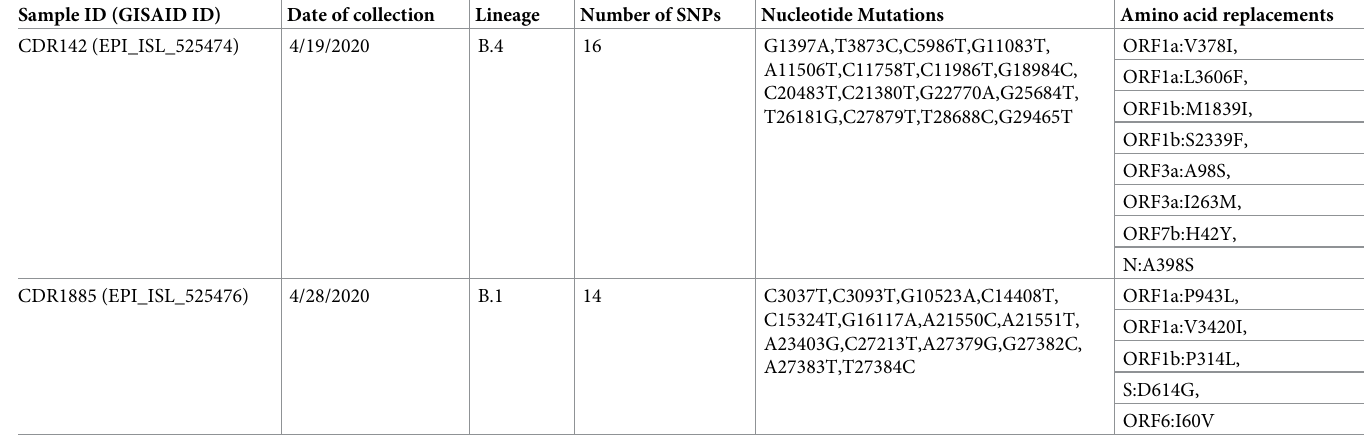
Table 3. Type and number of mutations and the Pangolin lineage details of the SARS-CoV-2 viruses sequenced during this outbreak. Sample ID (GISAID